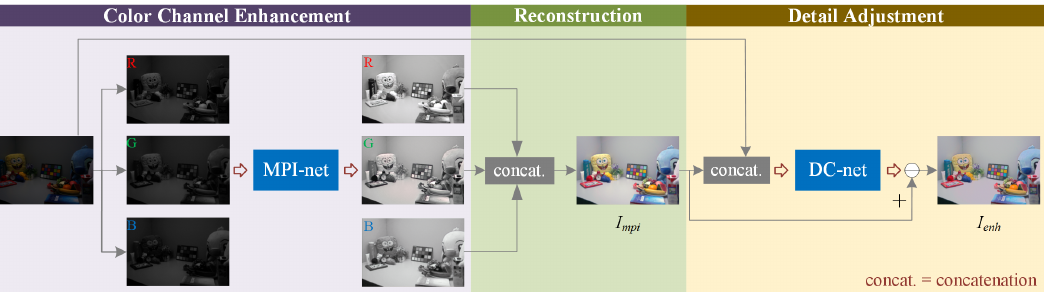
Figure 1. The architecture of the proposed method. The enhancement process is divided into three steps: color channel enhancement, reconstruction, detail adjustment. In the color channel enhancement step, a subnetwork MPI-net enhances the R, G, B channels. In the reconstruction step, the enhanced R, G, B channels are concatenated in order to generate the preliminary enhanced image I mpi . In the detail adjustment step, we concatenate the I mpi and the input image as the input of DC-net, and the output of DC-net is a residual map. The final enhanced image I enh is obtained by subtracting the residual map from the I mpi